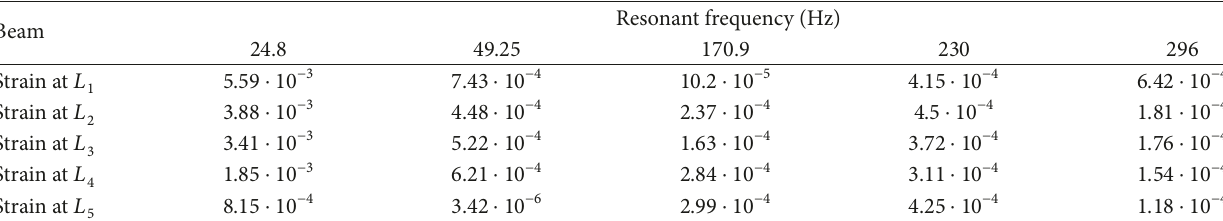
Table 3: Summary of the maximum strain